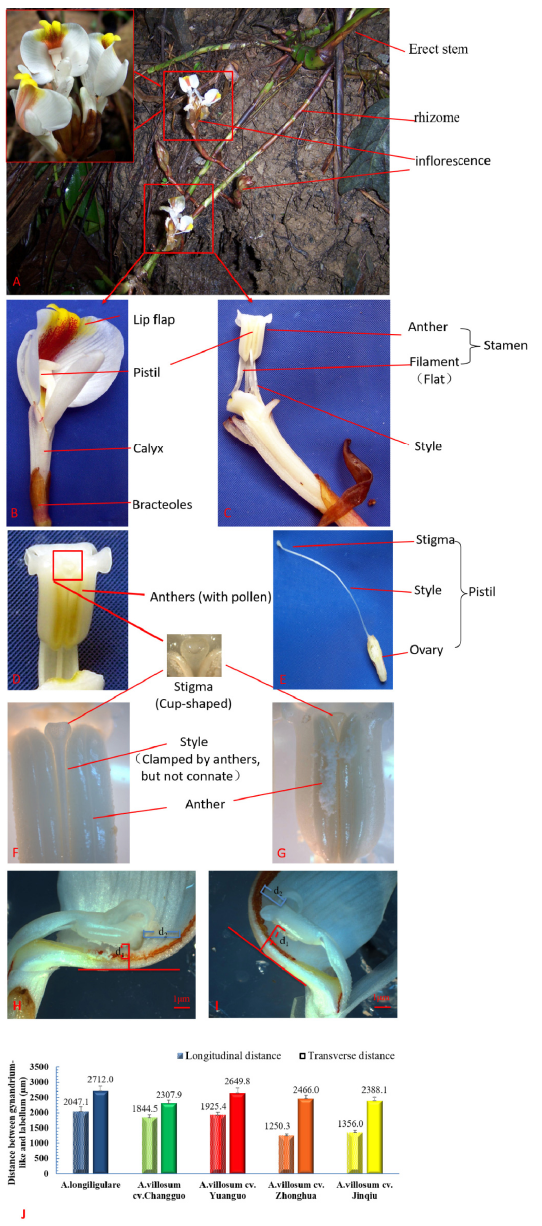
Fig 1. Anatomy of the flower-shaped structure of Amomum villosum. (A) The flowers on the inflorescence gradually open from bottom to top, (B) Whole flower, (C) Stamen, (D) Stigma and pollen sac (the position is higher than the anther, therefore, it is difficult for pollen to enter the cup), (E) Pistil, (F) Unexploded anther sac, (G) Pollen sac that is longitudinally split with the pollen grains outside, Illustration of the method for measuring longitudinal (H) and transverse (I) distances between gynandrium-like and labellum, (k) Histogram of distances between gynandrium- like and labellum of five Amomum germplasms (n = 9). 94.00%, while only one variety tested by in vitro germination exceeded 80.00% (Table 3). In vitro germination confirmed that the maximum germination rate of fresh pollen appeared in ‘ A . longiligulare ’ (83.59%), and the minimum pollen vitality appeared in ‘ A . villosum cv . Changguo’ (55.06%) (Table 3).